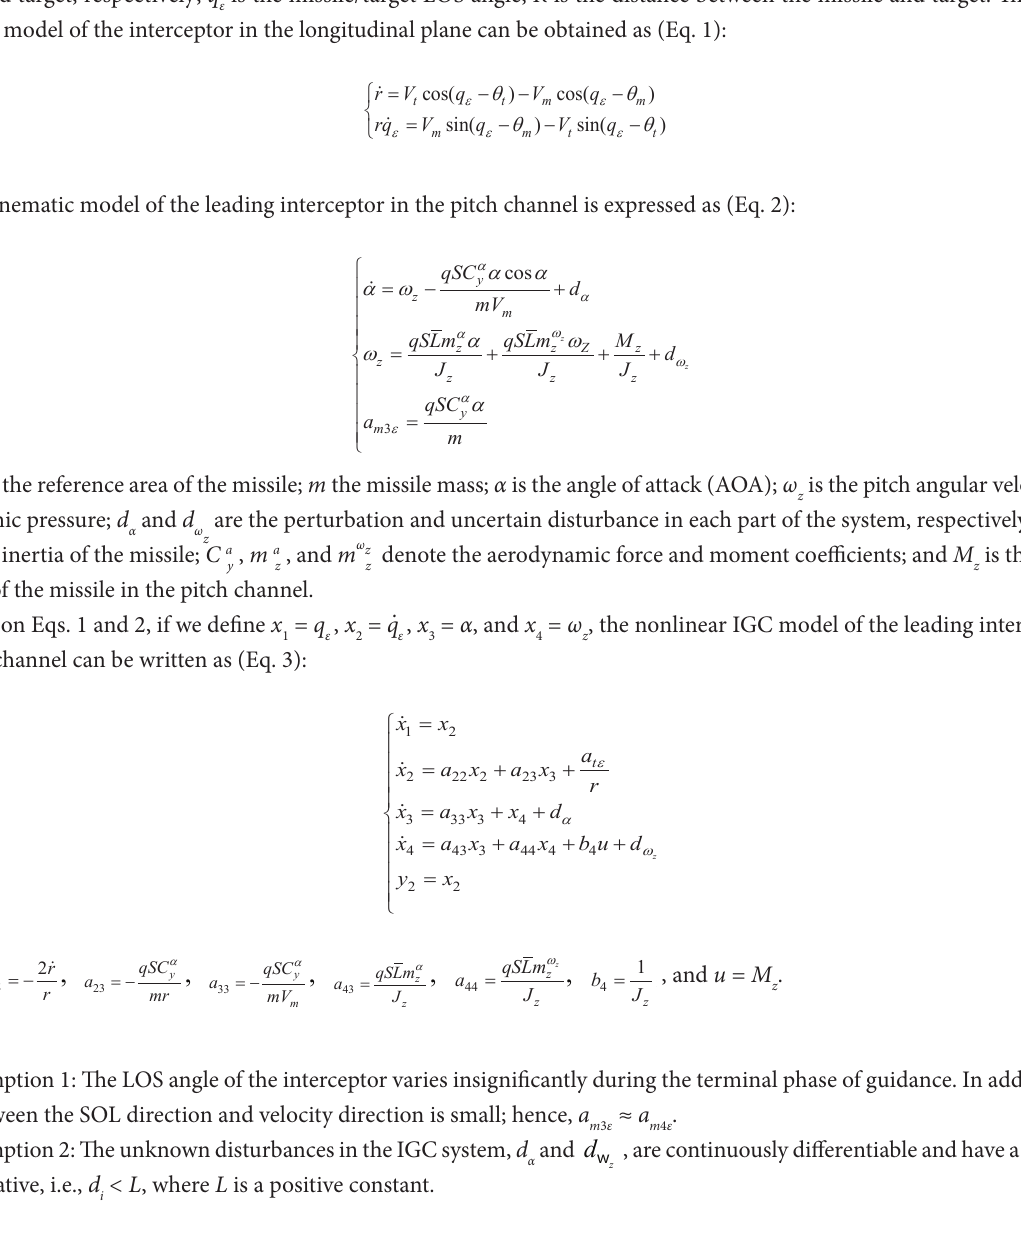
Figure 1. Engagement geometry of the leading interceptor and